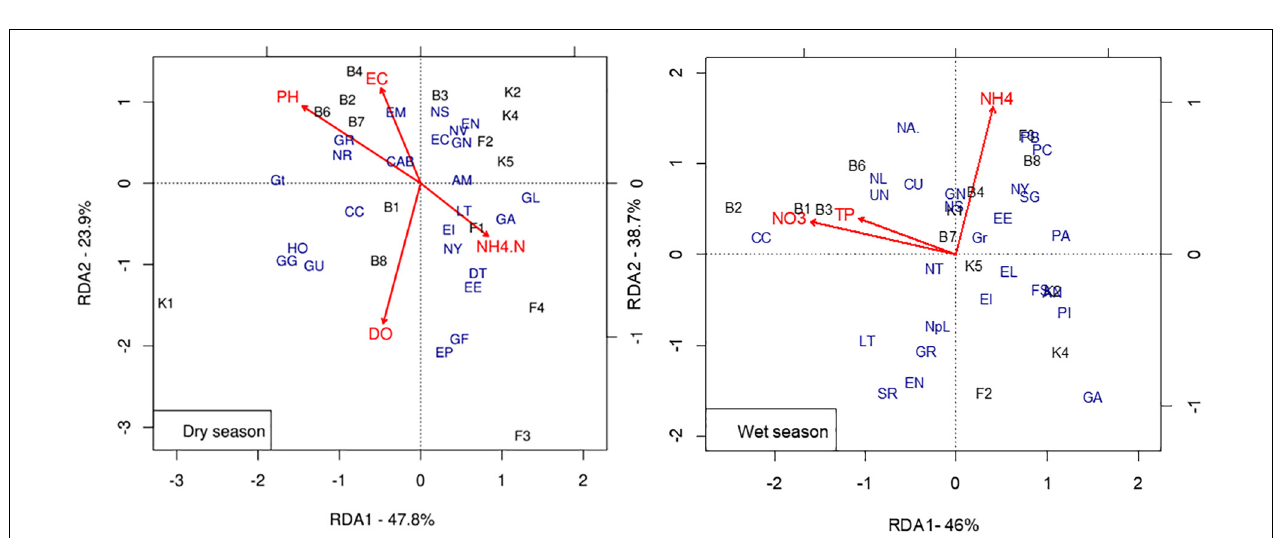
FIGURE 4 | Redundancy analysis triplot of macroinvertebrate taxa, environmental variables, and sites during the wet and dry seasons (see Supplementary Table S5 for full names of taxa codes and Supplementary Table S1 for the site codes). TUR, Turbidity; TN, Total Nitrogen; DO, Dissolved Oxygen; PO 4 , Ortho phosphate; NH 4 , Ammonium-Nitrogen; NO 3 , Nitrate Nitrogen; BOD, Biological Oxygen Demand.